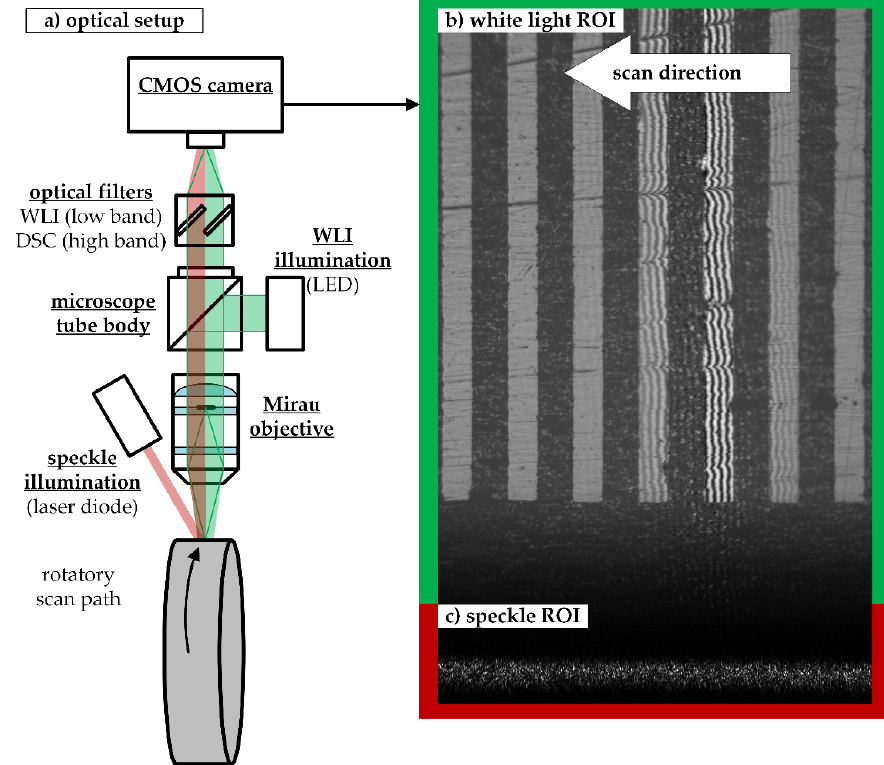
Figure 2. ( a ) Schematic illustration of the combined digital speckle correlation (DSC) and white light interferometry (WLI) measurement system. Green: light path for white light interferometry (WLI). Red: light path for digital speckle correlation (DSC). Right side: raw image showing both regions of interest (ROI) in the same field of view. ( b ) White light ROI. ( c ) Speckle ROI. The laser illumination profile is shaped with line optics to fit into the DSC ROI.